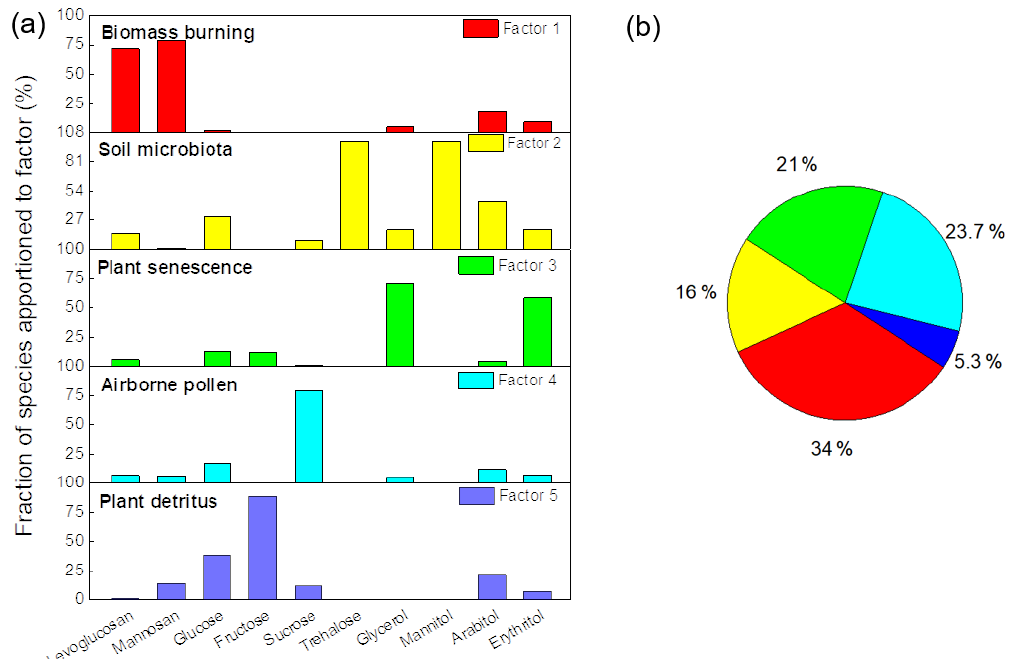
Figure 6. (a) Factor profile obtained by NMF analysis. (b) Source contribution of the five factors to the total saccharides in PM 2 . 5 samples.